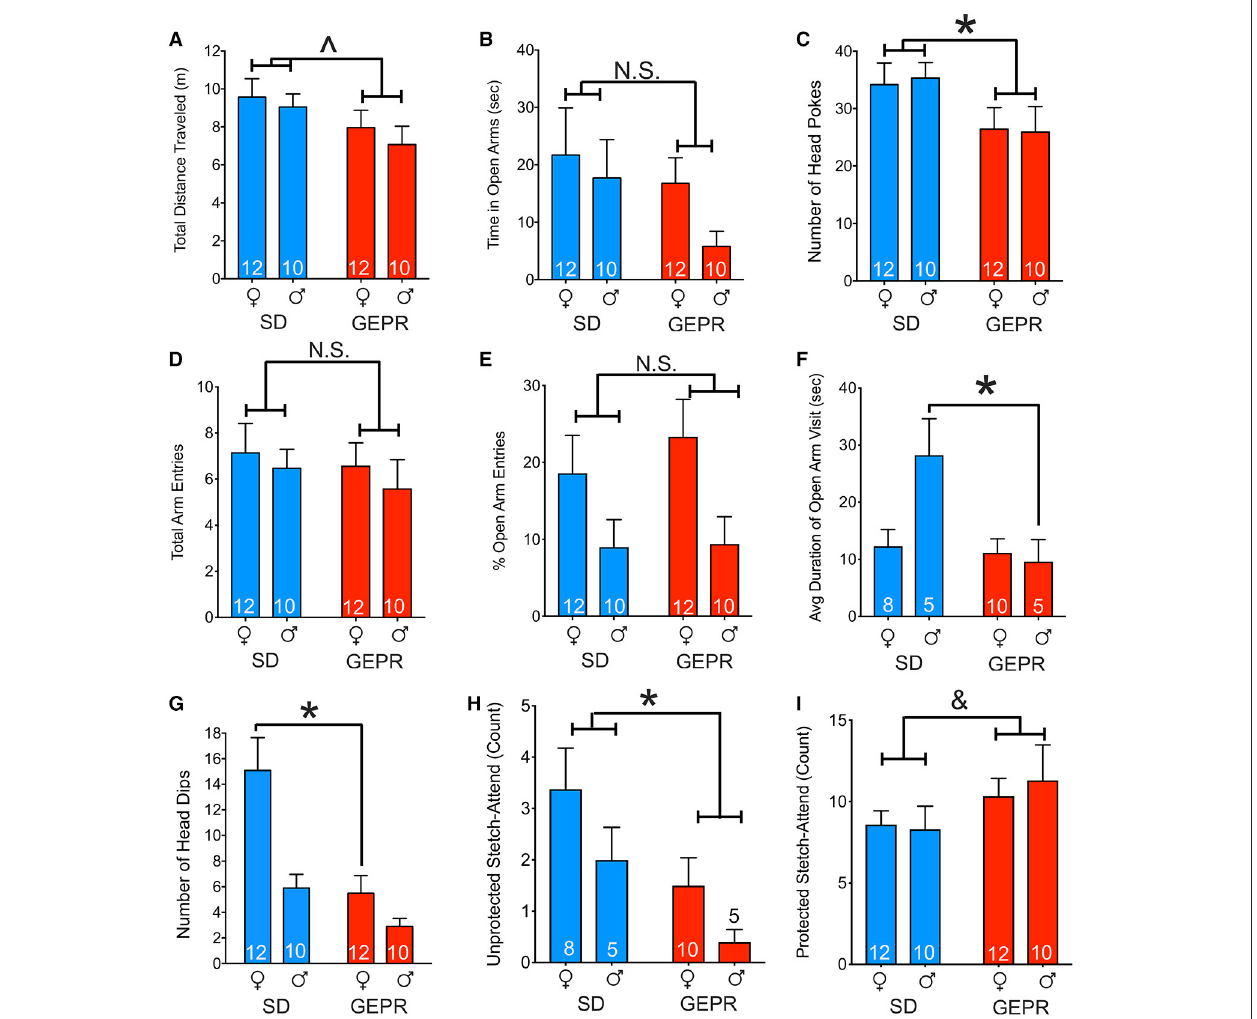
FIGURE 2 | Elevated plus maze. (A) Total distance traveled in the maze for the duration of the test (300s); GEPR-3s trending toward traveling less [ ∧ F (1,40) = 3.9, P = 0.055]. (B) Time spent in the open arms of the EPM did not differ by either strain or sex ( Ps = 0.18 and 0.23, respectively). (C) GEPR-3s displayed a decrease in number of head pokes into the open arms [* F (1,40) = 5.2, P = 0.03], but there was not an effect of sex. (D) , Total arm entries throughout the duration of the test did not differ significantly by either strain or sex ( Ps = 0.50 and 0.46, respectively). (E) Percent open arm entries differed by sex [ F (1,40) = 7.0, P = 0.01] but showed no effects of strain or strain-by-sex interaction ( Ps = 0.56 and 0.63, respectively). (F) Average duration of open arm visit differed by strain [ F (1,24) = 7.04, P = 0.01] and showed a significant interaction of sex-by-strain [ F (1,24) = 5.499, P = 0.03], driven by males (* P = 0.009). (G) Number of head dips off the open arms differed by sex [ F (1,40) = 7.04, P = 0.01] and strain [ F (1,40) = 13.7, P = 0.0006]. The strain effect driven by females ( P = 0.003). Accordingly, female GEPR-3s displayed fewer head dips than did female SDs (* P = 0.008). (H) Number of stretch-attend posture counts observed while the animal was in the “unprotected” portion of the maze (i.e., the open arms). SD rats has a higher frequency of this behavior as compared to GEPR-3s [* F (1,24) = 6.5, P = 0.018]. There was a trend toward an effect of sex [ F (1,24) = 3.3, P = 0.08] but no strain-by-sex interaction ( P = 0.8). (I) Number of stretch-attend posture counts observed while the animal was in the “protected” portion of the maze (i.e., the closed arms). There was a trend toward an effect of strain [ & F (1,40) = 2.9, P = 0.098] with GEPR-3s showing a greater number of this risk-assessing behavior than SD rats. There was neither an effect of sex, nor a strain by sex interaction ( Ps = 0.81 and 0.67, respectively). Figures show mean and standard error of the